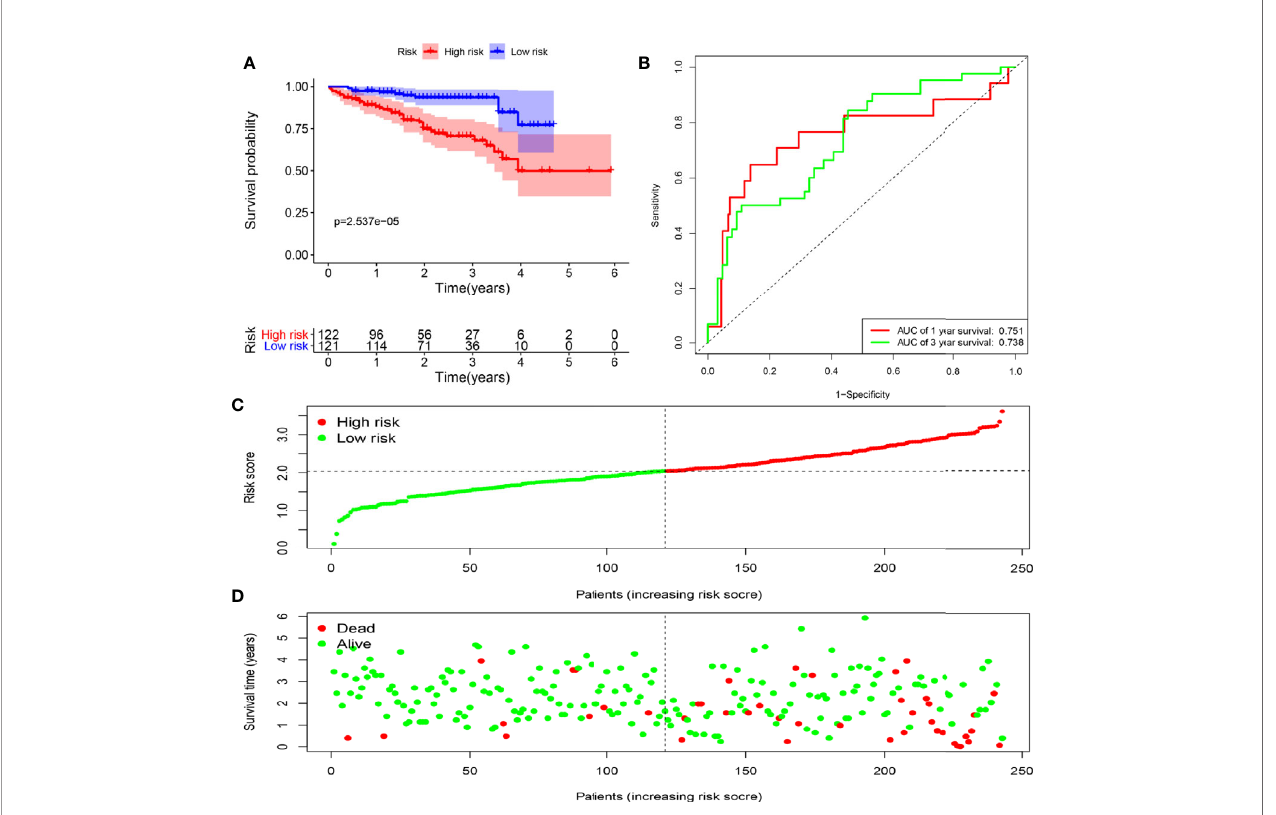
FIGURE 7 | Determination of risk scores by the prognostic model in the ICGC dataset. (A) Survival analysis of high- and low-risk groups. (B) ROC curves analysis of the prognostic model. (C) The risk score distribution of HCC patients. (D) The survival status of patients in the ICGC